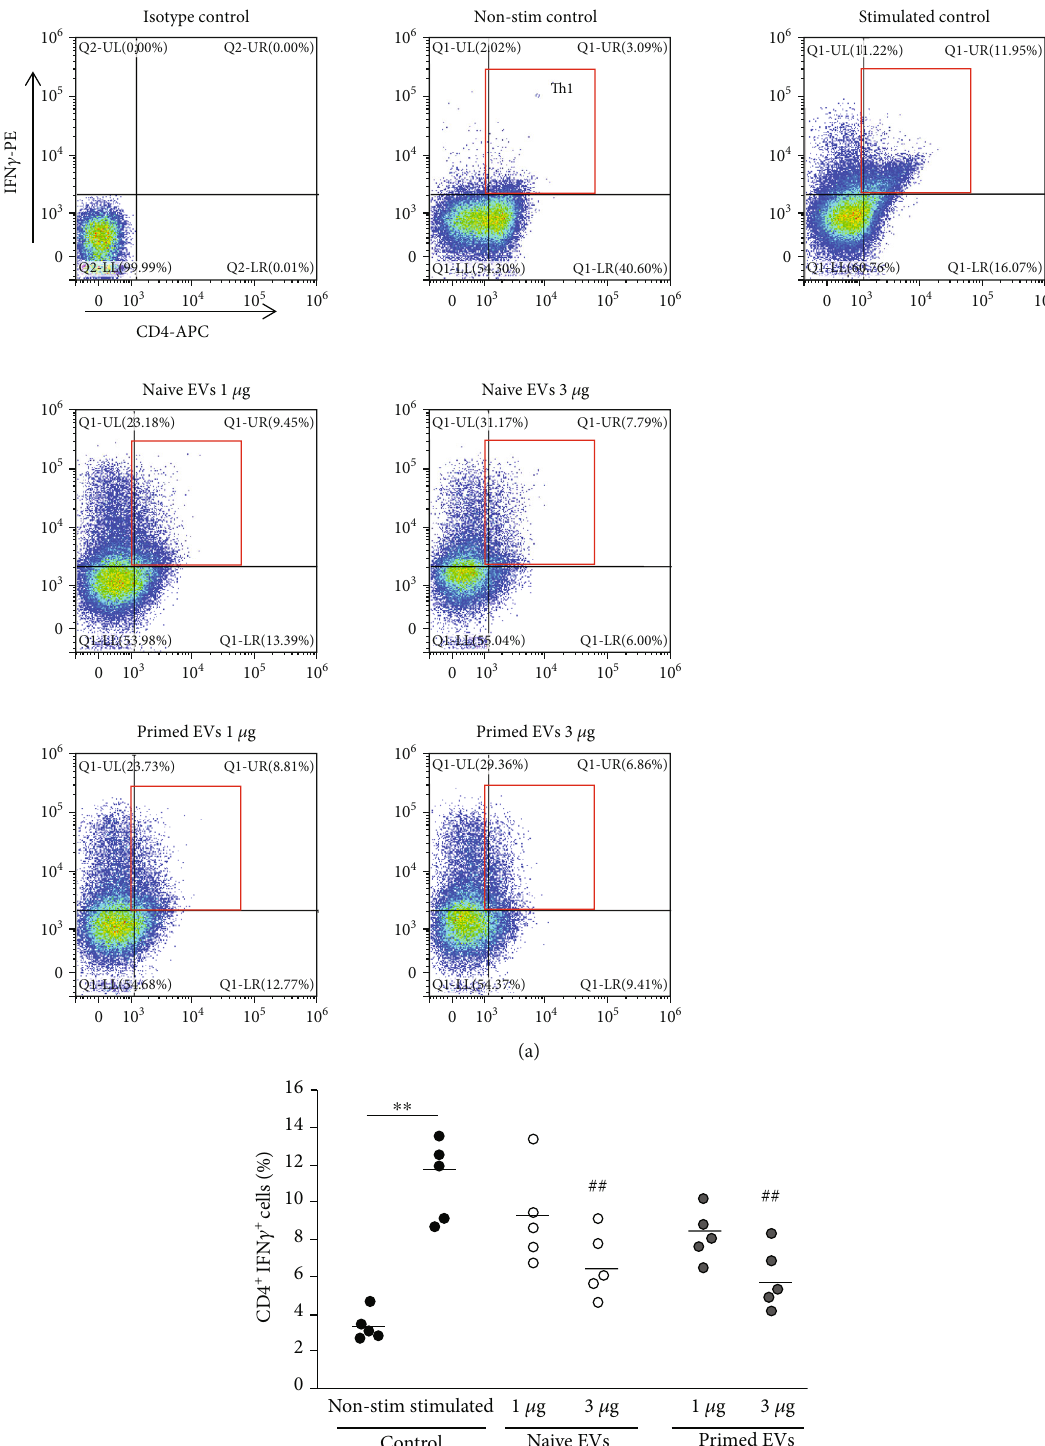
Figure 7: Di ff erentiation into Th1 cells after coculture of PBMCs with cADSC-EVs. (a) Flow cytometric detection of CD4 + IFN γ + cells among CD3 + T cells (gated in red square). Non-stim control: PBMCs that were not stimulated with PMA and ionomycin. Stimulated control: PBMCs after coculture with cADSC-EVs and stimulated by PMA and ionomycin. (b) Comparison of CD4 + IFN γ + cells among CD3 + T cells after coculture of PBMCs with various concentrations (1 or 3 μ g/ml) of naive or primed cADSC-EVs. The ratio of Th1 cells was not signi fi cantly di ff erent between naive and primed EVs at the same concentrations. The solid line indicates the average. ## P < 0 : 01 vs. stimulated control. ∗∗ P < 0 : 01 , between